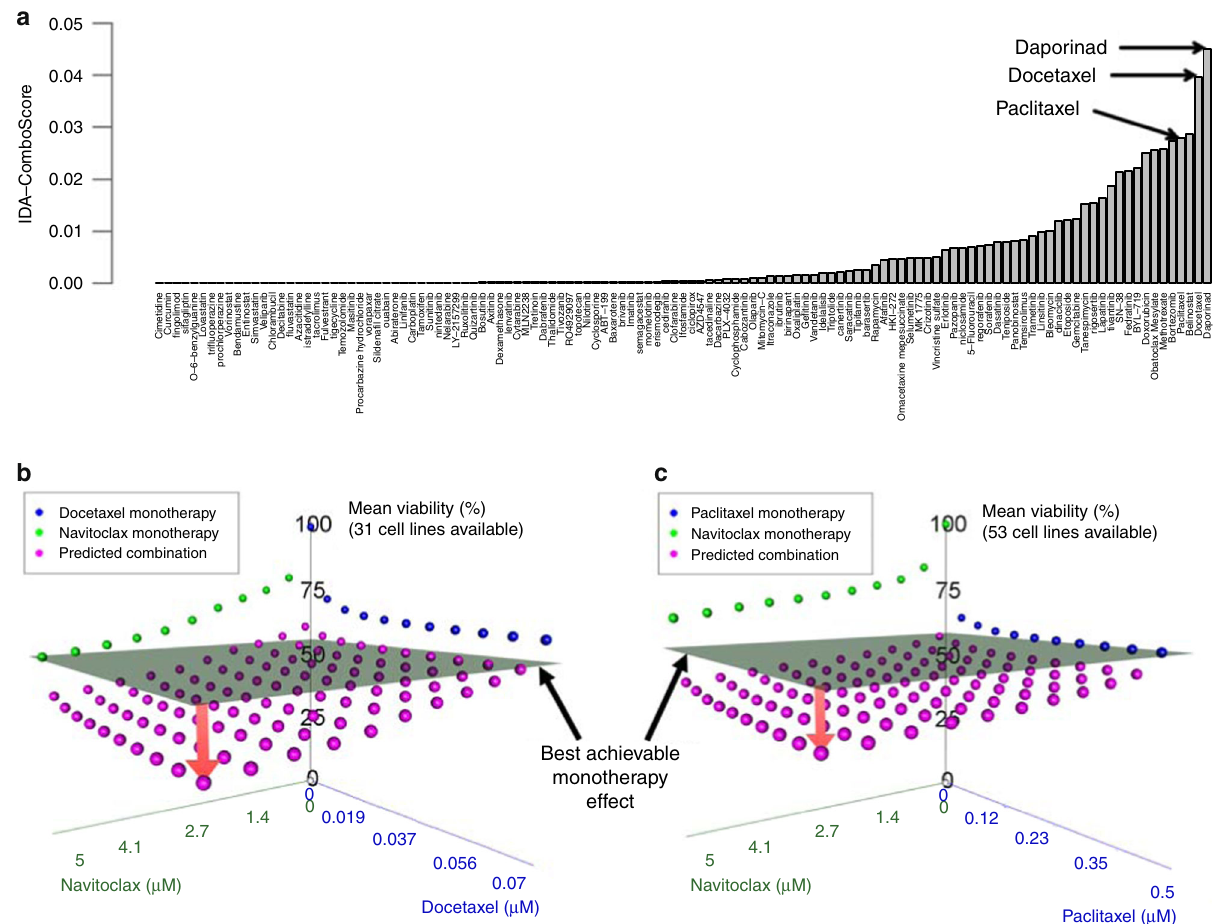
Fig. 6 IDA-Combo predicts strong bene fi ts for combinations of navitoclax and taxanes in EGFR -WT lung cancer. a An ordered bar plot of the IDA- comboscores predicted using EGFR -WT lung cancer cell lines for combinations of navitoclax with other drugs that have reached late-stage clinical trials. Each bar represents a different combination of navitoclax with another drug. b and c 3-D plots of measured and predicted average cell viabilities at different concentrations of navitoclax and docetaxel b or paclitaxel c . The gray plane represents the lowest average viability achievable with monotherapy. The red arrow represents the difference between the best observed monotherapy effect and the best predicted combination effect, which suggests that the combination therapy will reduce tumor cell viability below what is achievable with monotherapy alone. Source data are provided as a Source Data fi